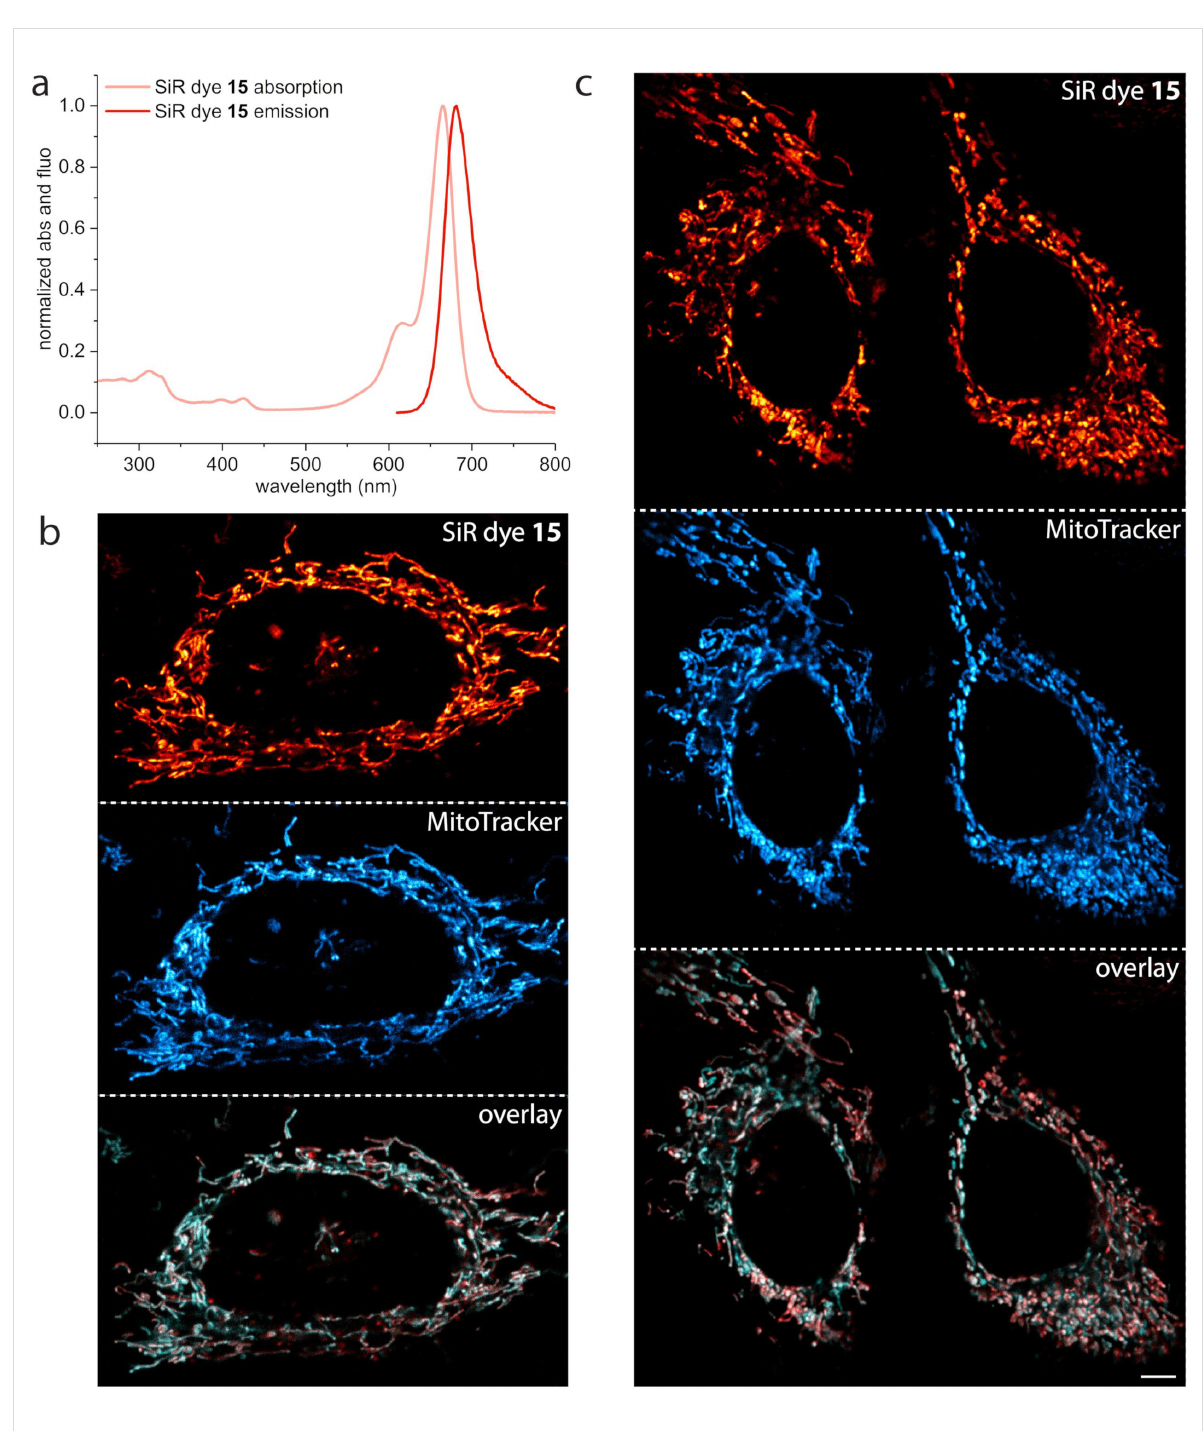
Figure 1: (a) Absorption and fluorescence emission spectra of dye 15 measured in PBS buffer pH 7.4. (b, c) Colocalization experiment of dye 15 (red) and MitoTracker ® Green FM (cyan) in living HeLa (b) and U2OS (c) cells supporting the application of dye 15 as a specific NIR mito tracker probe. Both cell lines were incubated for 0.5 h with 1 µM of dye 15 and 100 nM of MitoTracker ® Green FM, washed and imaged with excitation at 470 nm (380 µW) and 652 nm (7.5 µW). Confocal images are color shift and background corrected, scale bar 5 µm.